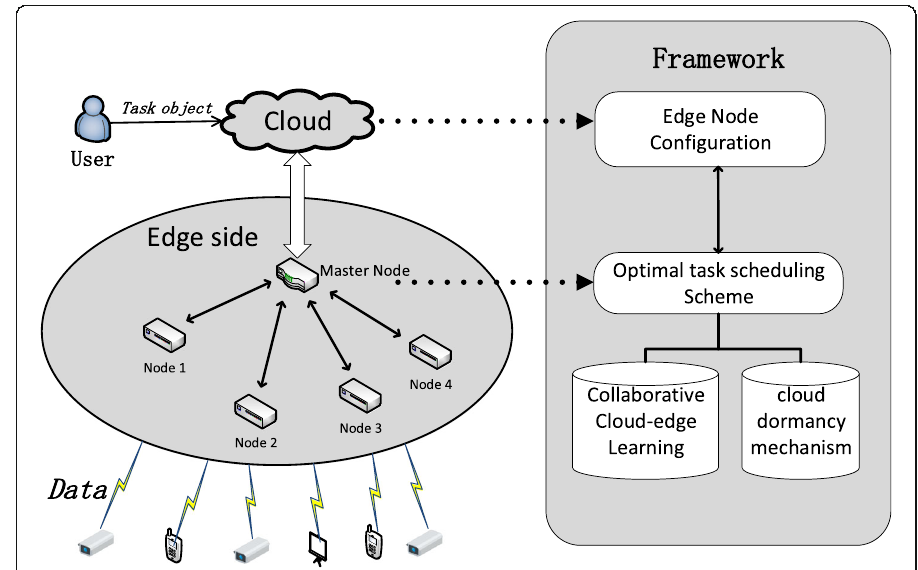
Fig. 1 The collaborative cloud-edge computing framework. The main parts of our framework, including cloud side, edge side, and device